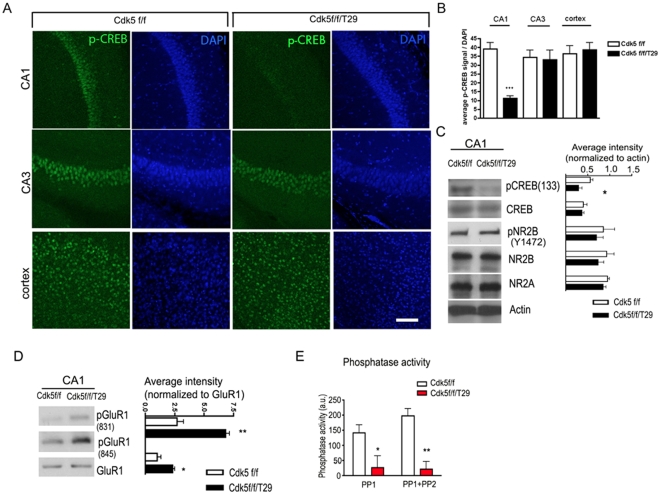
Impaired CREB phosphorylation and hyper-phorsphorylation of GluR1 in Cdk5f/f/T29 mice.
A–B. Immunostaining (A) and quantification (B) of pCREB in hippocampal CA1 and cortex. Scale bar = 100 µm. C. Western blots of micro-dissected CA1 tissue show reduced pCREB levels. D. Western blots of micro-dissected CA1 tissue reveals hyper-phosphorylation of GluR1. E. Area CA1 phosphatase activity in Cdk5f/f and Cdk5f/f/T29 mice (n = 3, each group). *p<0.05, **p<0.005, ***p<0.001.